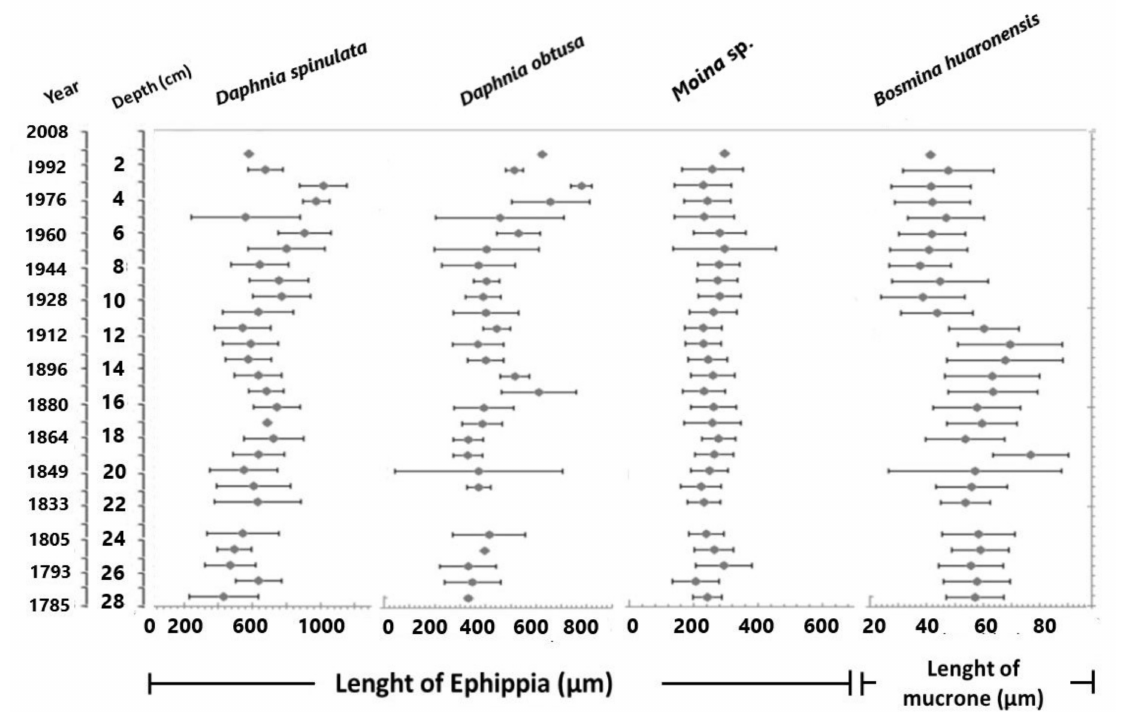
Figure 3. Size of the ephippia of Daphnia species and Moina sp. and the mucrone of Bosmina huaronensis in the sedimentary record of Lake Blanca Chica.